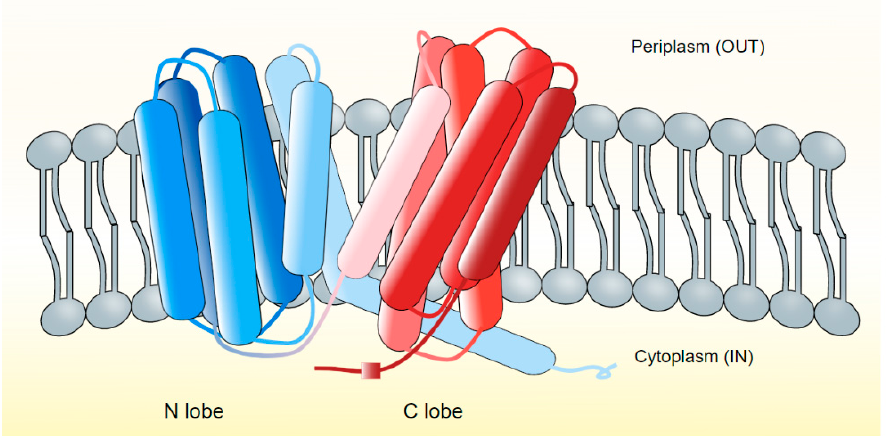
Figure 1. MATE transporters of bacteria. The transporters are grouped under NorM and DinF subfamilies and are generally composed of 12 TM helices which fold into two distinct N- (TM1-TM6) and C- (TM7-TM12) lobes [76,84,93]. The topology of MATE transporters is characteristically distinct from that of MFS transporters, many of which have similar 12 TM helices [76,94]. In the NorM subfamily (NorM-VC), the C-lobe functions as a cation binding site, and two acidic amino acid residues, Glu255 and Asp371, are located between TM7-12, are critically important for this function [83].